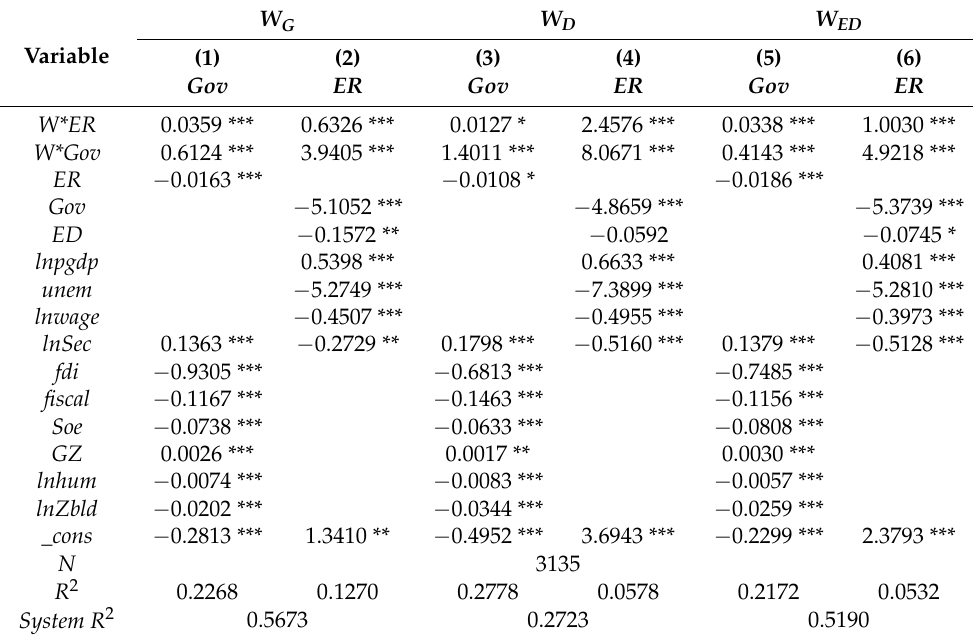
Table 3. Whole-sample estimation results under three spatial weight